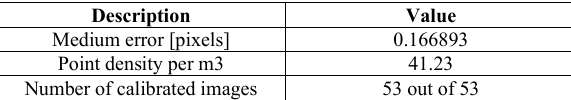
Table 2: Results values in case reconstruction case